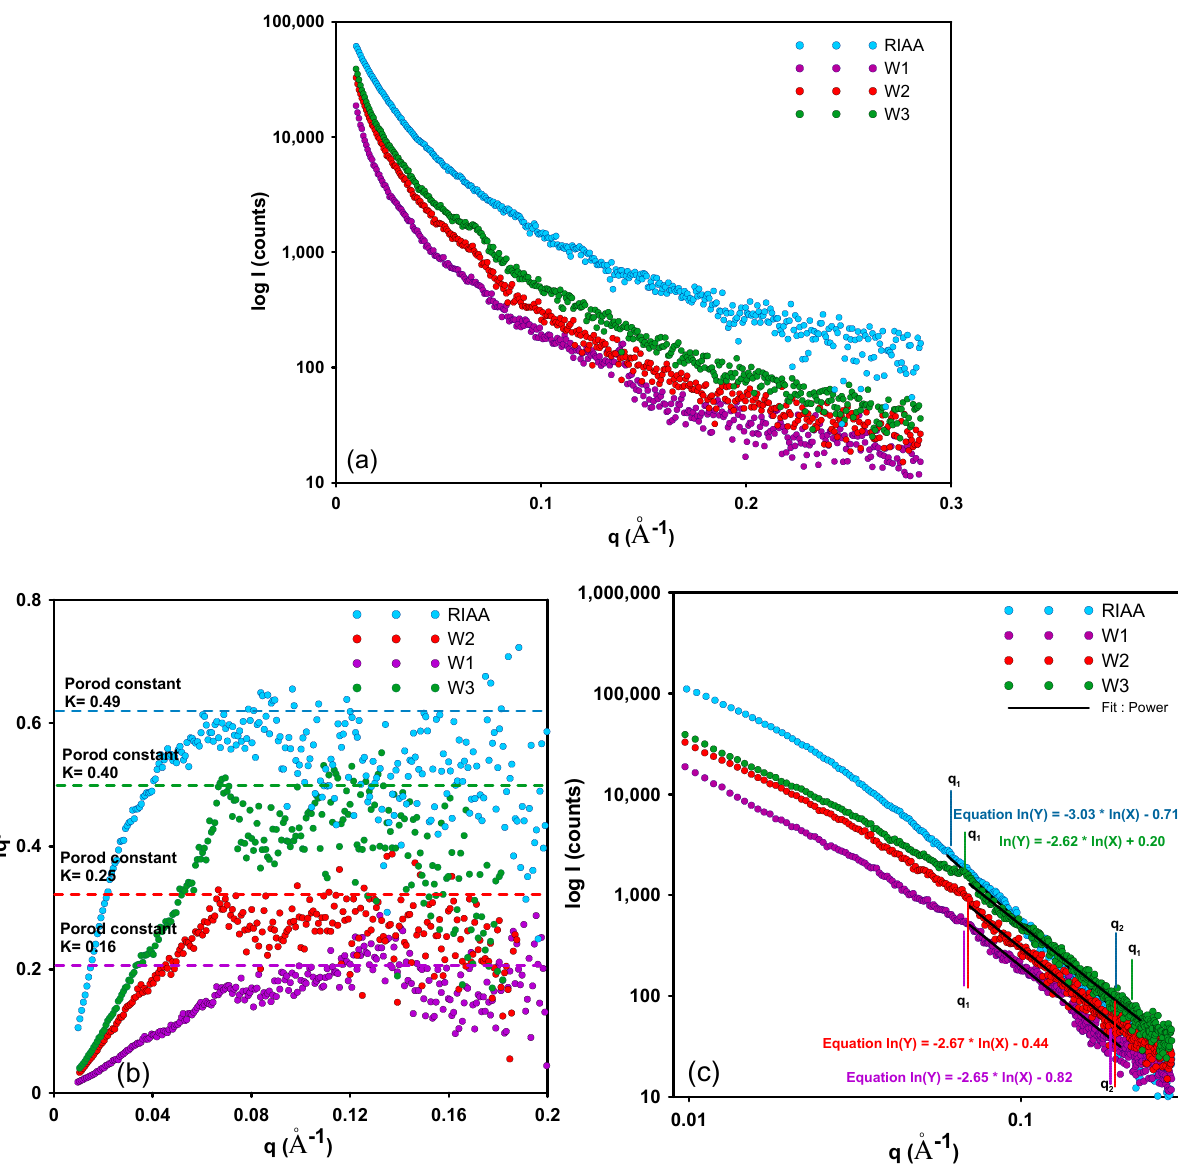
Figure 2. ( a ) Experimental SAXS curves for the investigated materials; ( b ) Porod plots with the slit-collimation calculated for the investigated systems; ( c ) The log-log plots of SAXS intensity in the power-law range for the investigated carbons containing a linear range of Porod area with power approximation.